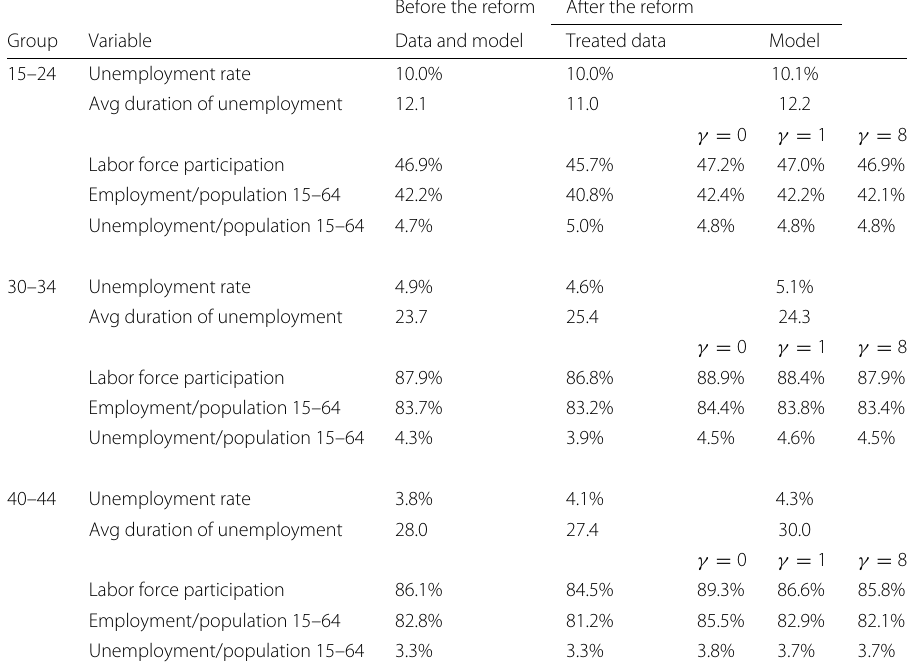
Table 6 Data and predictions of the model Before the reform After the reform Group Variable Data and model Treated